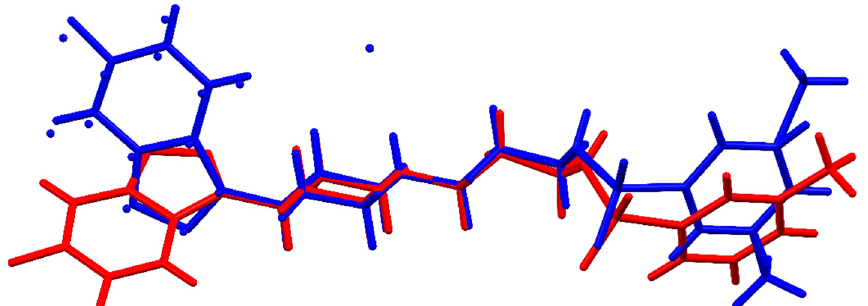
Figure 4. Overlay of MBS (red) and MBS HCl (blue) molecules extracted from their crystal structures.